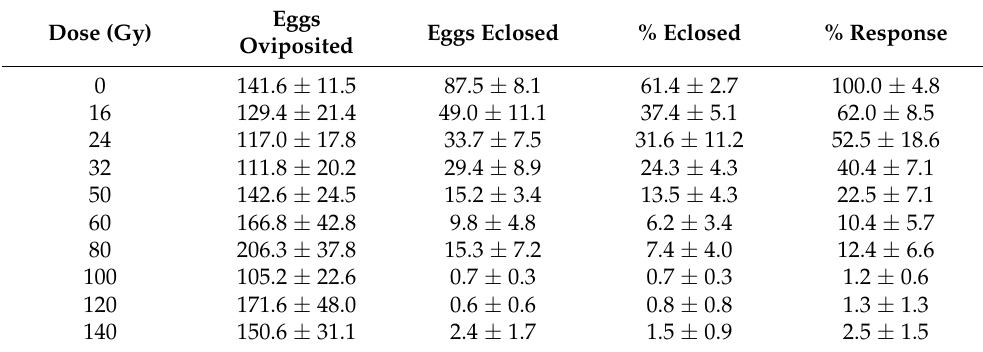
Table A1. Fecundity and fertility values (mean ± s.e.) of Bagrada hilaris in treatment 1 (IM/FF: irradiated male × fertile female) at different irradiation doses.